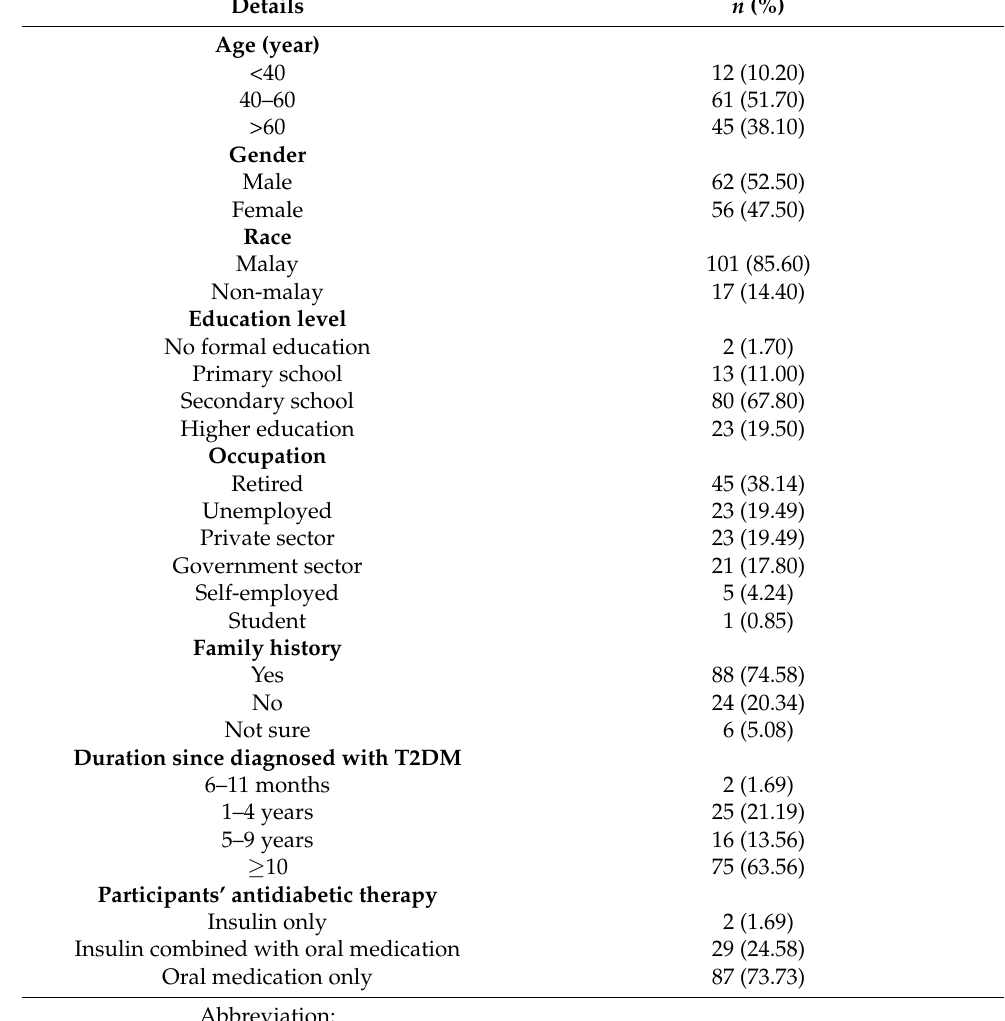
Table 1. Sociodemographic details of participants ( n =